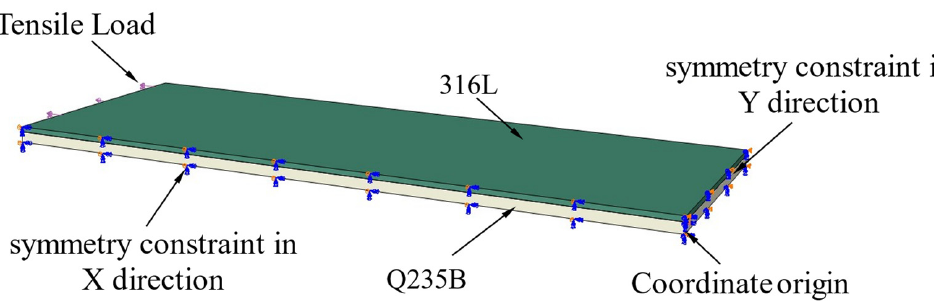
Figure 13. Finite element simulation model of 316L/Q235B composite plate.